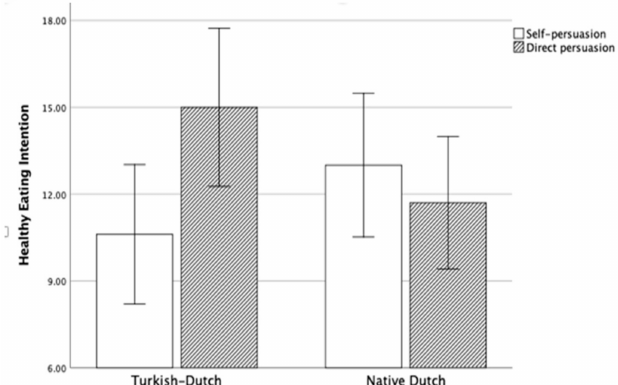
Figure 2. The interaction between persuasion and cultural background in the o ffl ine version in Study